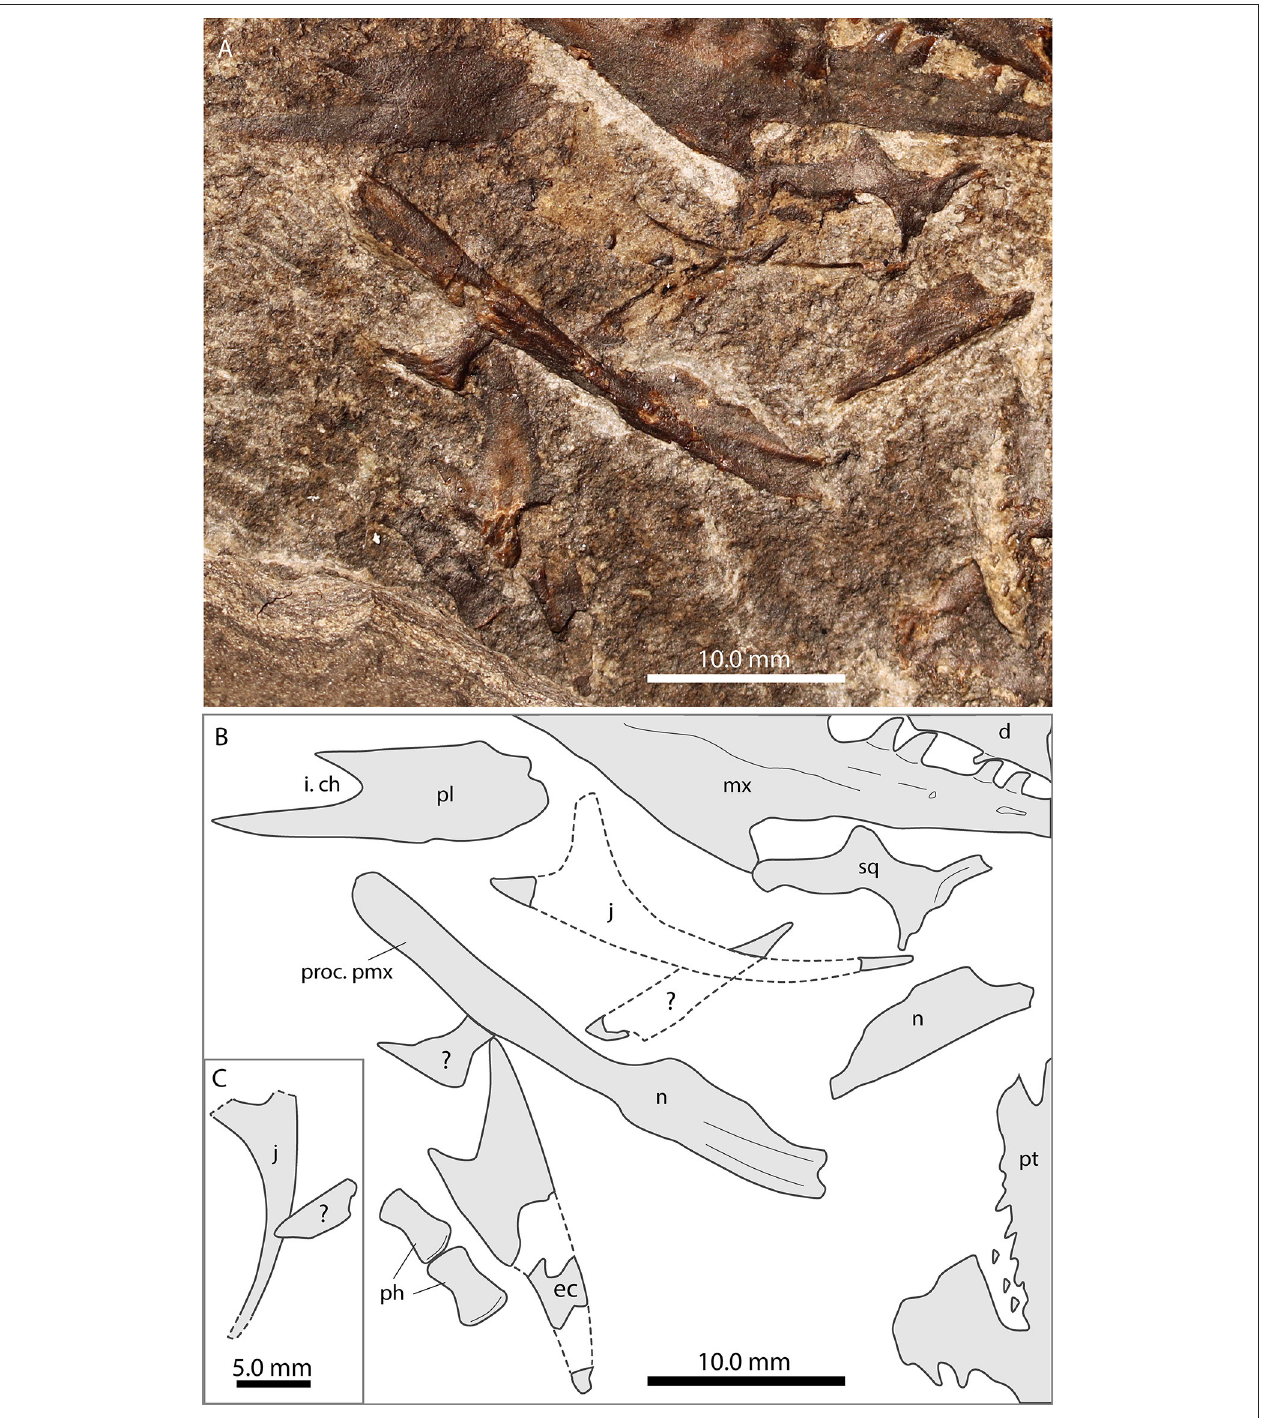
FIGURE 4 | Focus on the nasals and the jugal of PIMUZ T 1559. (A) Photograph; (B) interpretative drawing. Note long premaxillary process of nasal.